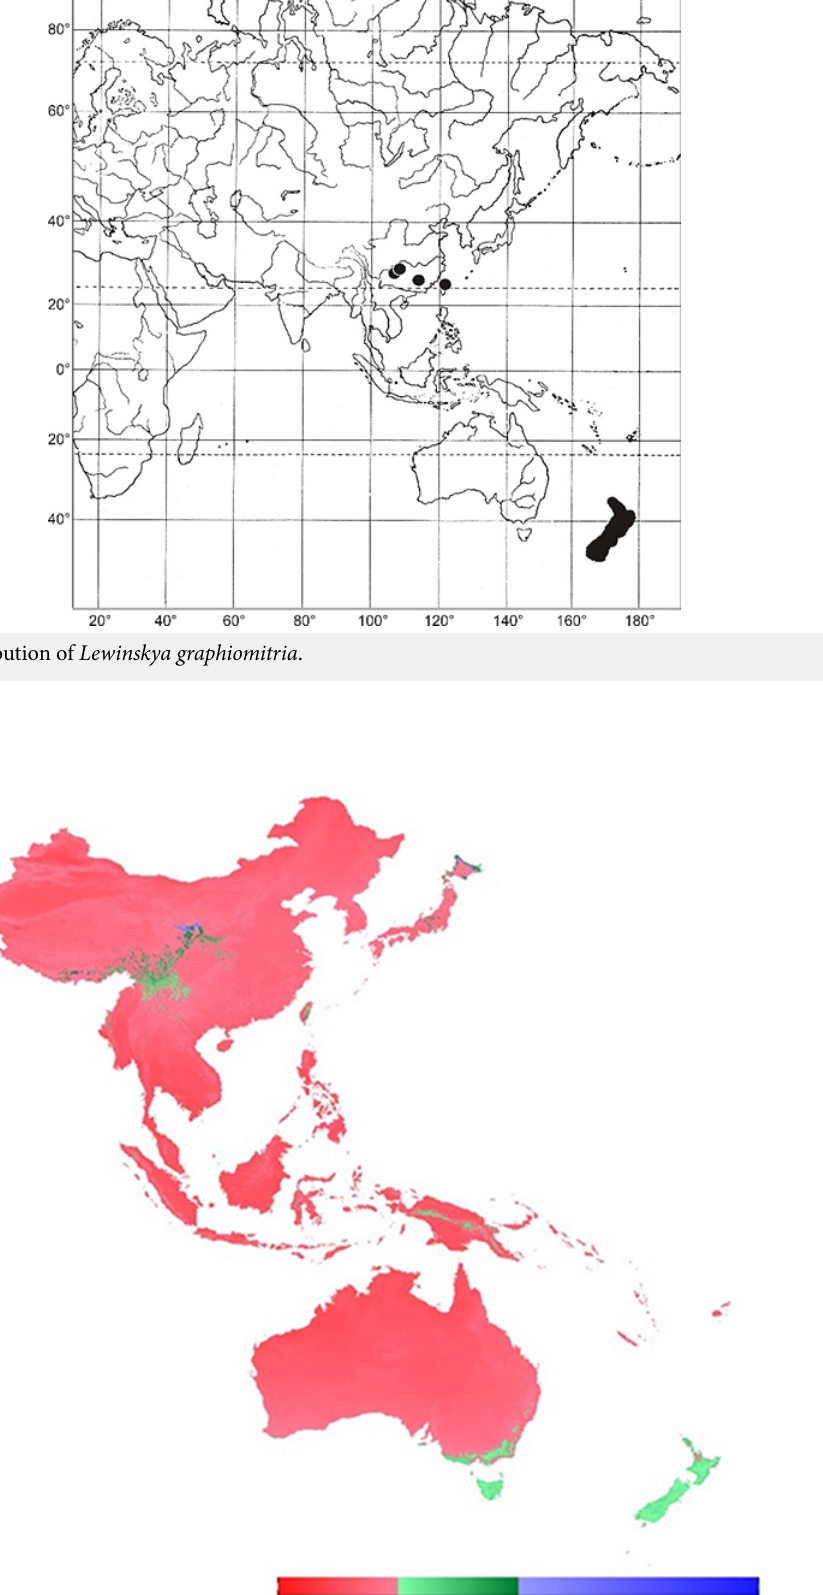
ActaSocietatisBotanicorumPoloniae /2020/Volume89/Issue3/Article8932 Publisher: